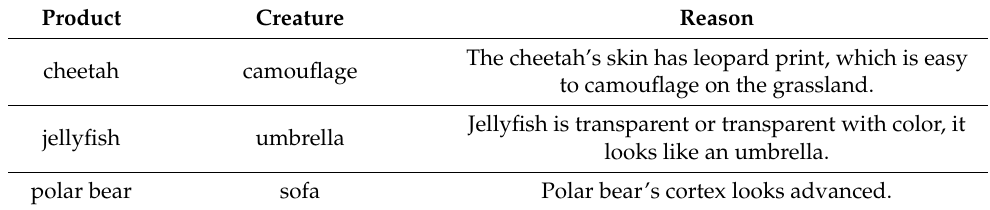
Table 9. Creature material- product material reasoning (26